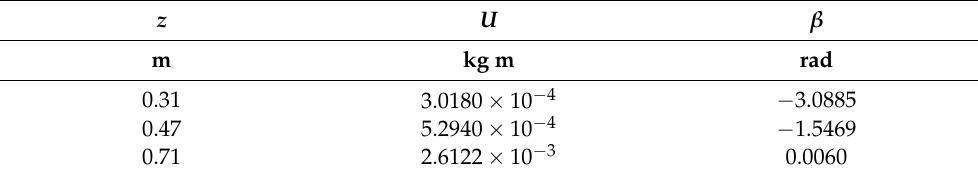
Table 6. Balancing weights of case B.